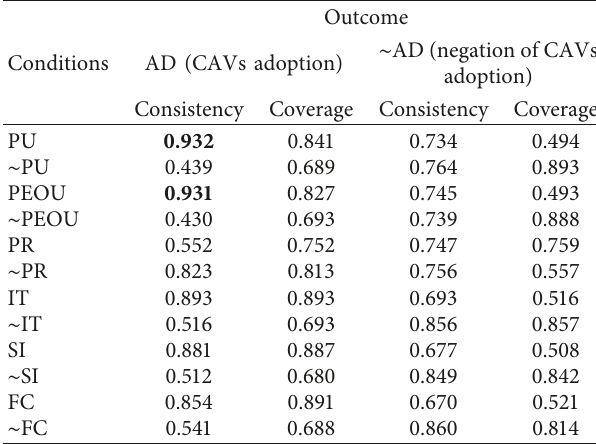
Table 9: Analysis of necessary conditions.